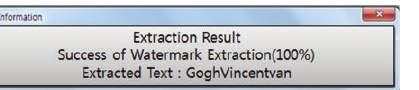
Figure 10: Screen for extraction result of